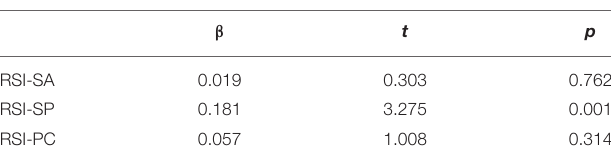
TABLE 8 | RSI scores predicting social